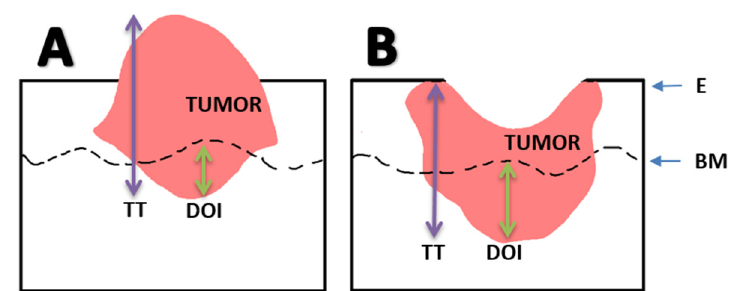
Figure 1. Measuring depth of invasion in an exophytic ( A ) versus ulcerative ( B ) tumor. Even